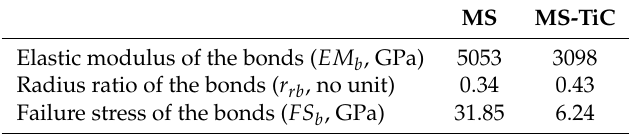
Figure 5. Calibration domain and boundary conditions for the MS (red) and MS-TiC (yellow). Table 2. Identified parameters of the beams for the steel and Metal Matrix Composite.